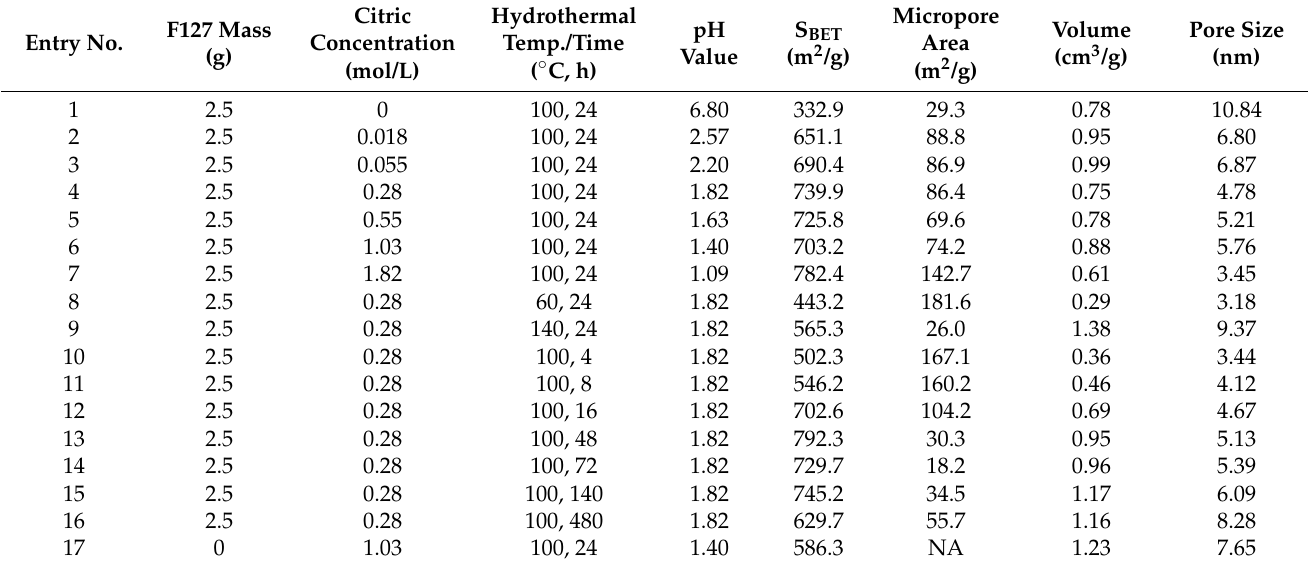
Table 1. Preparation conditions and physicochemical properties of the synthesized hierarchical mesoporous silica.